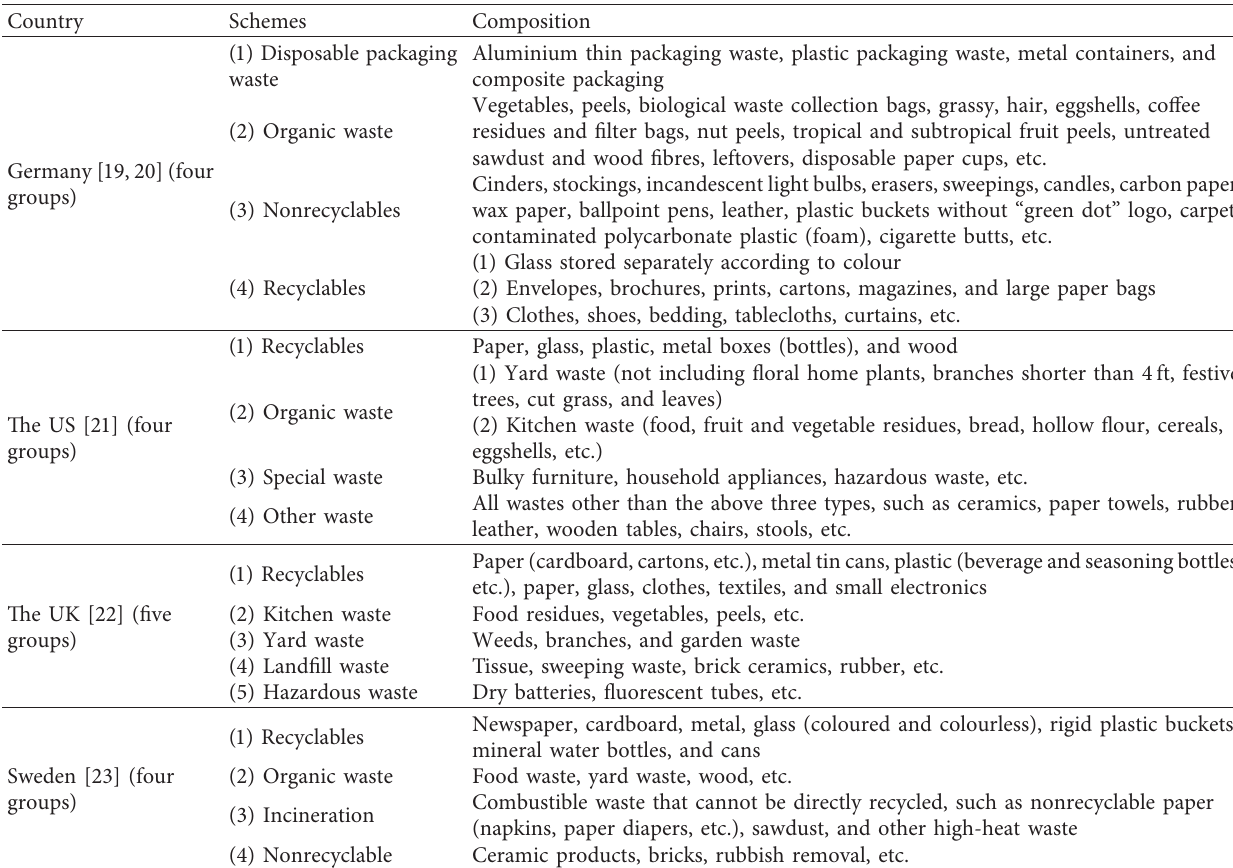
Table 2: Classification schemes in Germany, the US, the UK, Sweden, and